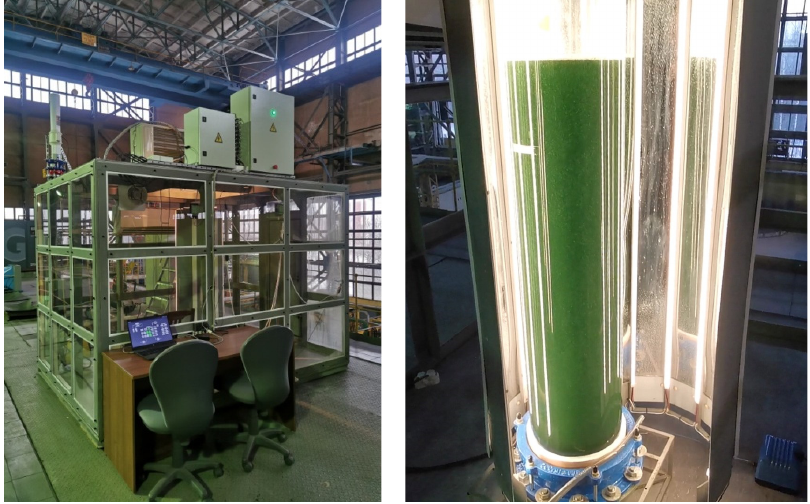
Figure 2. A view of atmospheric gas chamber (AGC) with a photobioreactor (PBR) inside the chamber.